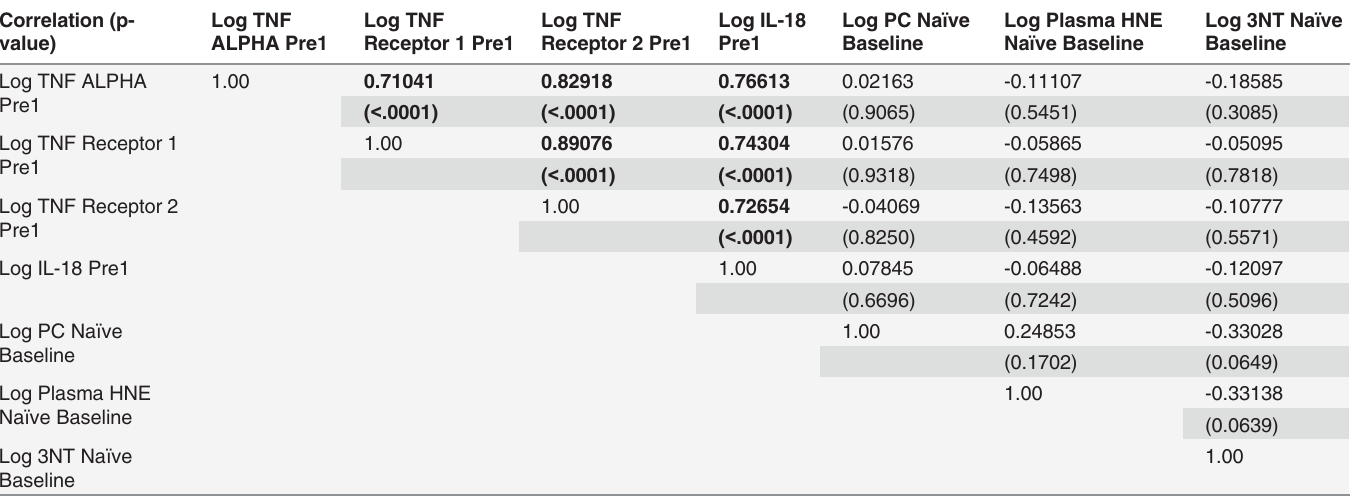
Table 2. Spearman Correlations between Baseline Measures.